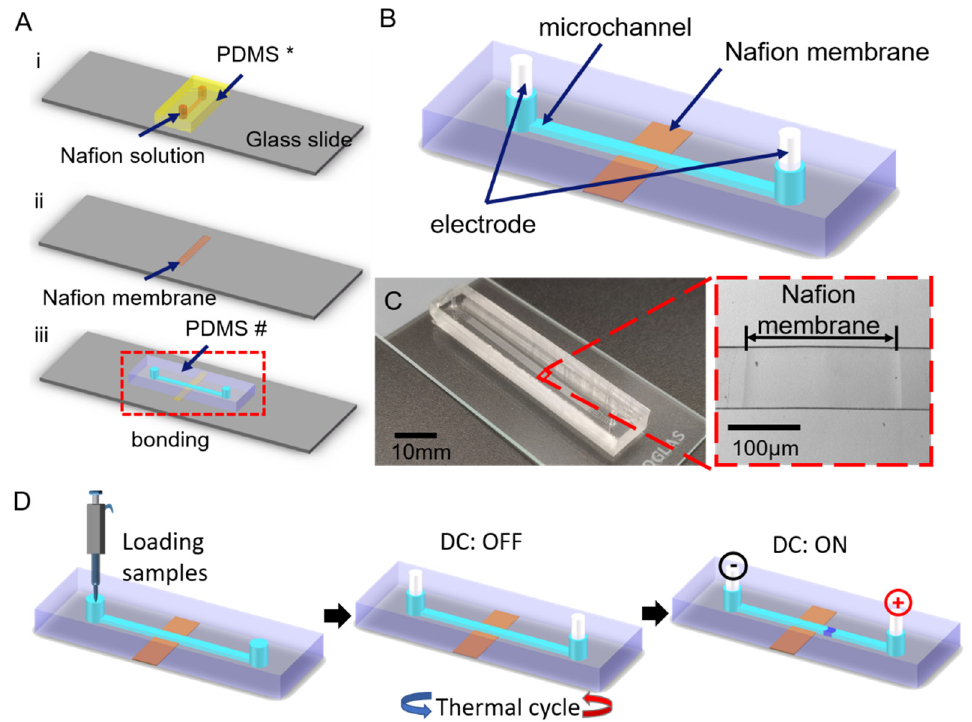
Figure 2. ( A ) Fabrication steps of the device. ( i ) Fabrication of Nafion membrane using PDMS *. ( ii ) Nafion membrane formed on glass substrate. ( iii ) Bonding with PDMS #. ( B ) The specific structure of the PDMS chip. ( C ) The experimental device and the optical micrograph of the Nafion membrane (40 mm length, 100 μ m width, and 30 μ m depth). ( D ) Steps of PCR-ICP hybrid experimental operation.